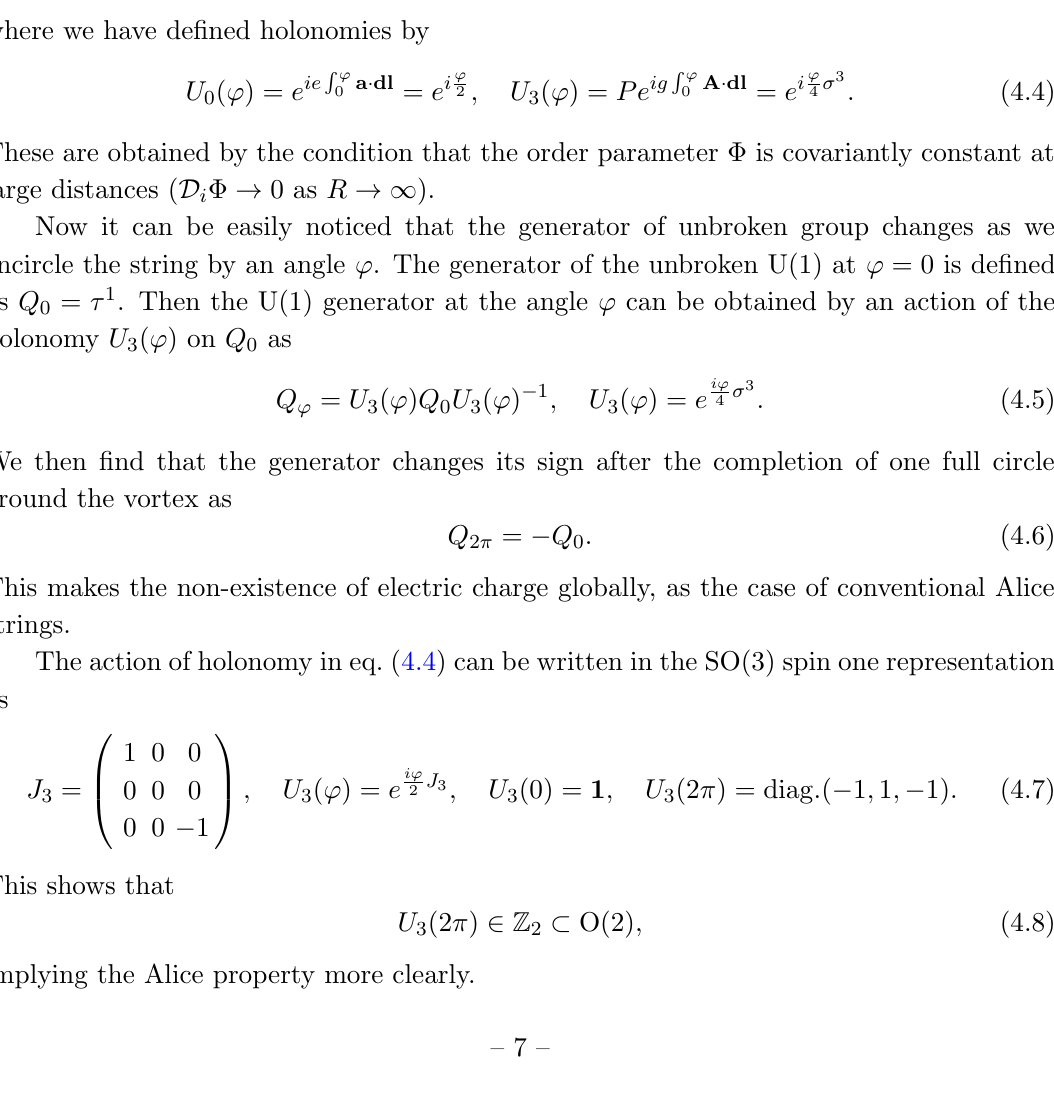
Figure 2. The Alice string is schematically shown. The Abelian and non-Abelian magnetic (cid:12)elds along the x 3 axis are denoted by ~B 0 and ~B 3 , respectively. The change of the electric charge of the unbroken U(1) is displayed by denoting Q 0 at ’ = 0 and Q ’ for arbitrary azimuthal angle outside the